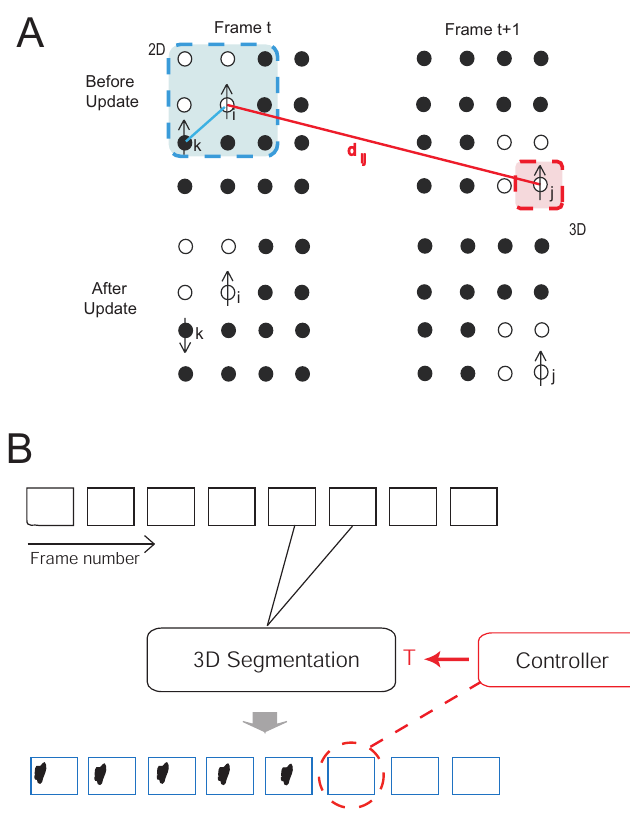
Figure 1. A The spin states (upward and downward pointing arrows) of pixels i , k , and j are shown before and after a spin update for two adjacent frames t and t +1 of an image sequence. The white and black circles indicate pixels of small and large gray values, respectively. Pixel i interacts with pixels k and j in its 2D and 3D neighborhood (shaded areas), respectively, which are in the same spin state. B Pairwise (3D) segmentation of movies. A feedback controller detects segmentation instabilities and adjusts the control parameter T of the core algorithm (3D segmentation) to recover lost